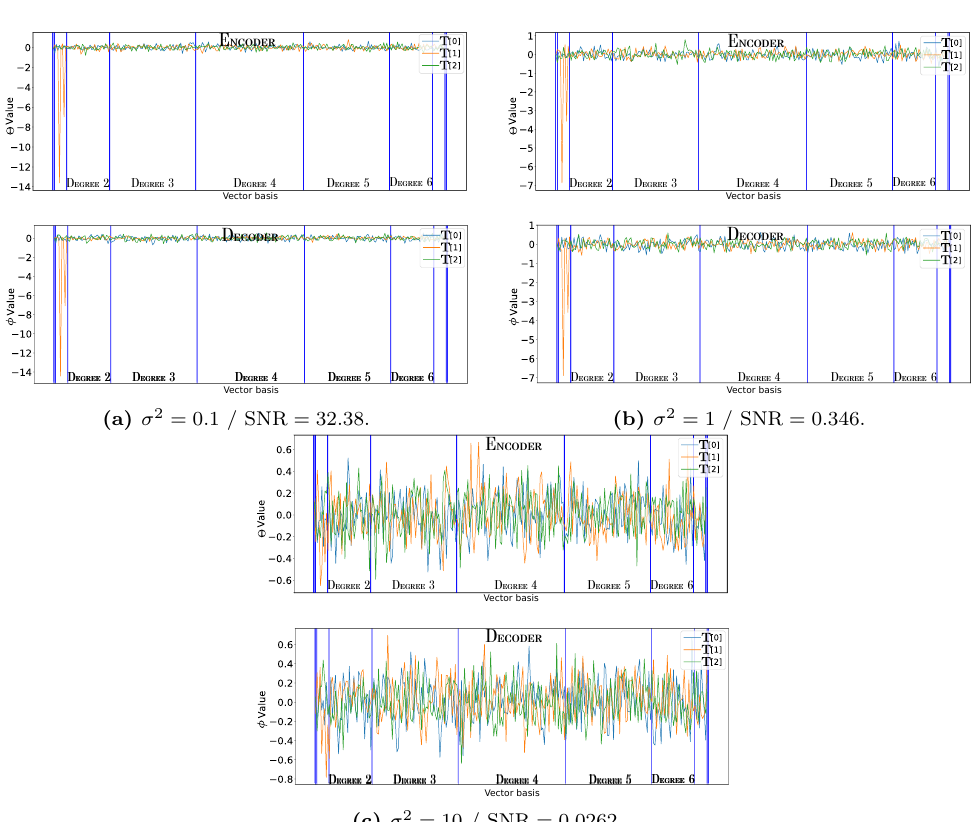
Figure 11: Weight visualization of the ˆ ψ Θ layer (encoder) and the ˆ ψ φ layer (decoder) for Scenario 3